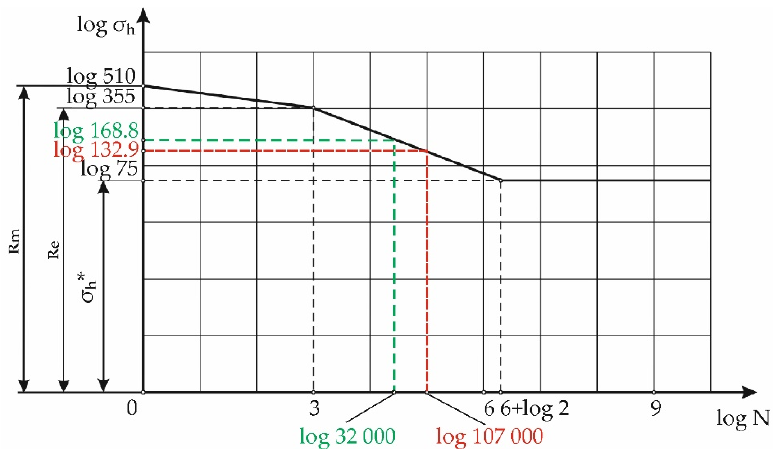
Figure A3. The fatigue curve of the anchor bolt under a disappearing load.